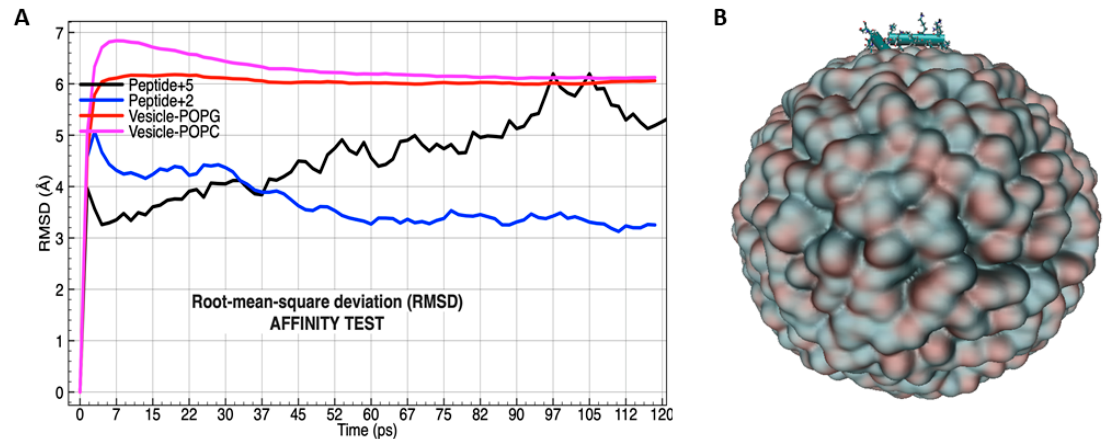
Figure 7. RMSD (root mean square deviation) by affinity test between peptide +2 (blue line) and peptide +5 (black line) in accordance with POPG and POPC (red and magenta lines, respectively) phospholipids in vesicle conformation ( A ). Molecular orientation of peptide onto lipid bilayer conformation in double layered spherical vesicle POPC and POPG ( B ). Peptide is shown by CPK coloring convention, and the vesicle by the drawing method that use the isosurface extracted from a volumetric Gaussian density map, called: QuickSurf [53].